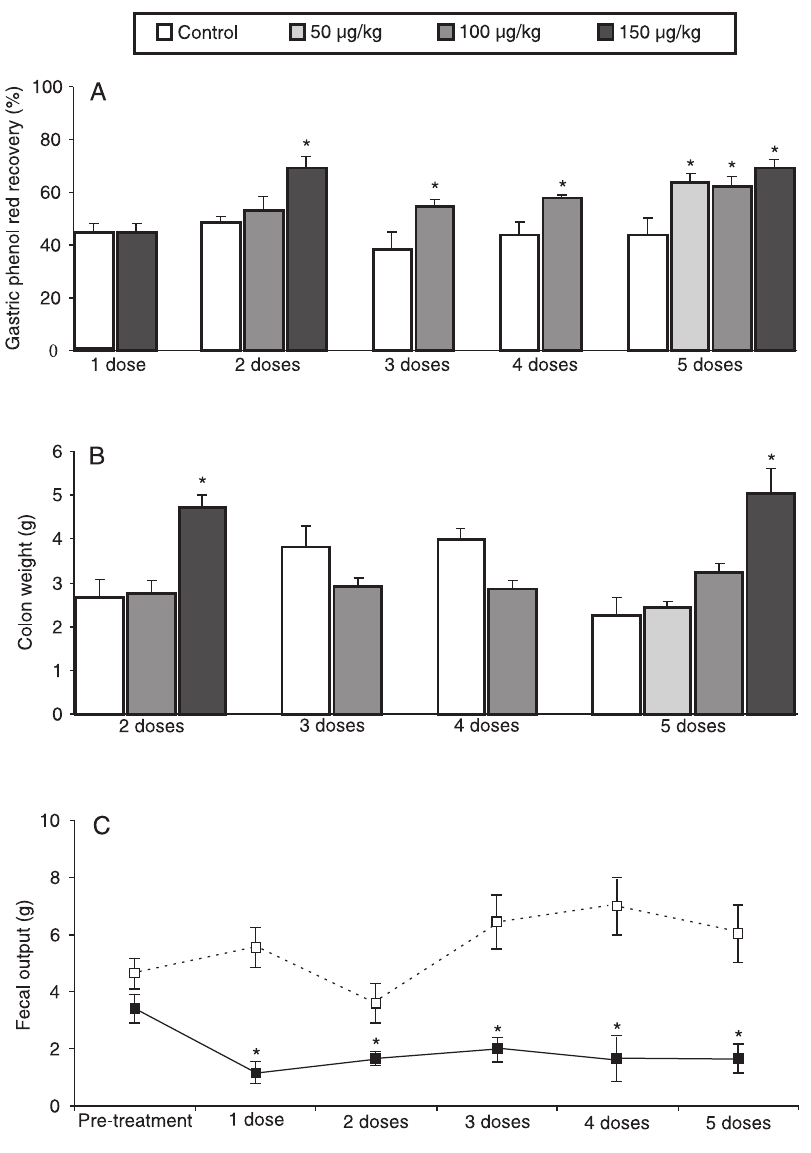
Figure 1. Effect of vincristine administered on alternate days on phenol red recovery (A), colon weight (B) and fecal output (C). Measurements were made 1 day after 5 doses of 50 μ g/kg vincristine administered iv; 2, 3, 4, and 5 doses of 100 μ g/kg, and 1, 2 and 5 doses of 150 μ g/kg. Data are reported as means ± SEM, N = 5-9. *P < 0.05 vs respective control (Student-Newman-Keuls